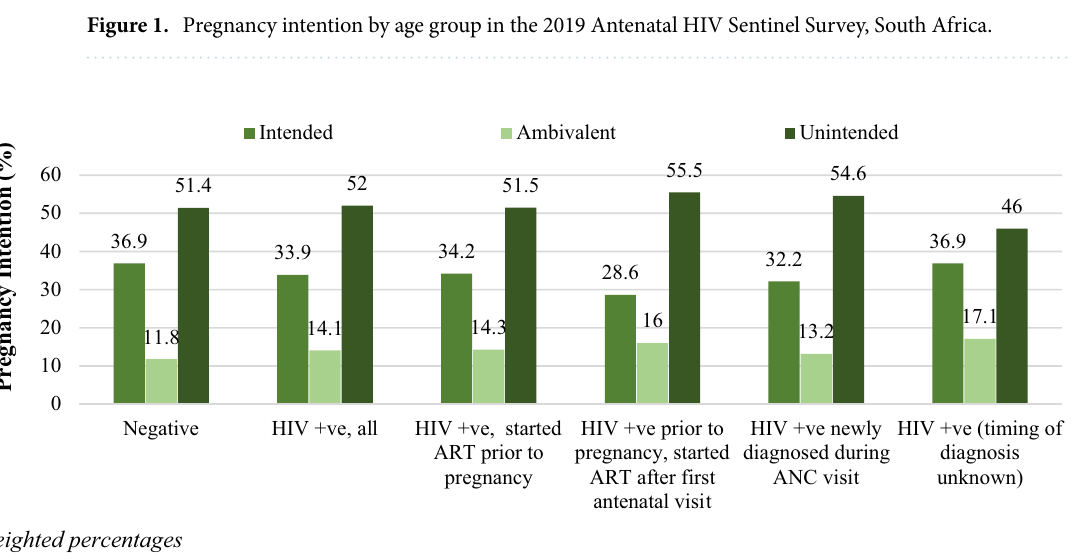
Figure 2. Pregnancy intention by HIV status in the 2019 Antenatal HIV Sentinel Survey, South